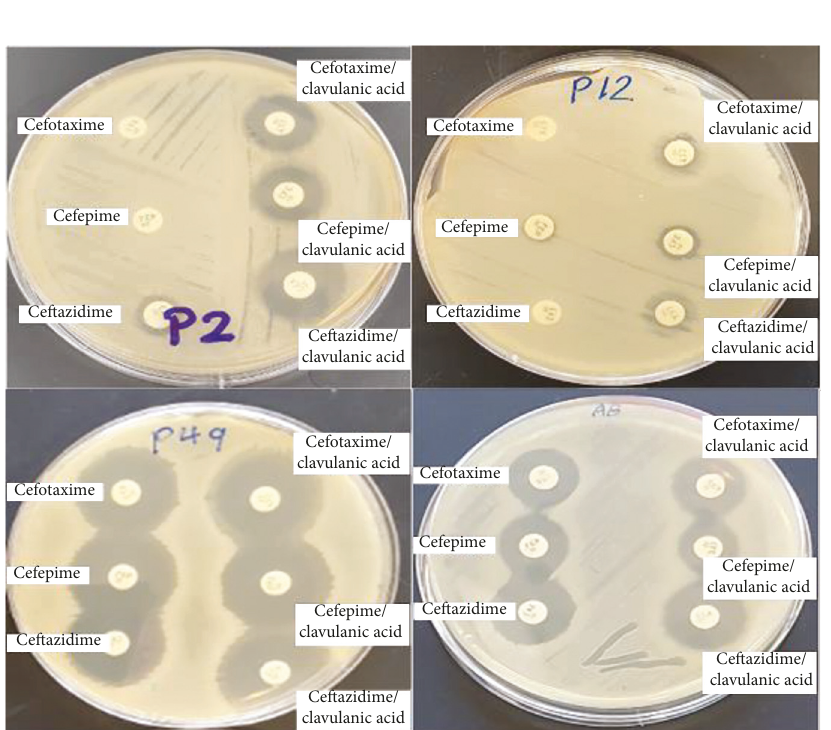
Figure 3: Combined disk test for phenotypic detection of ESBL-producing A. baumannii.